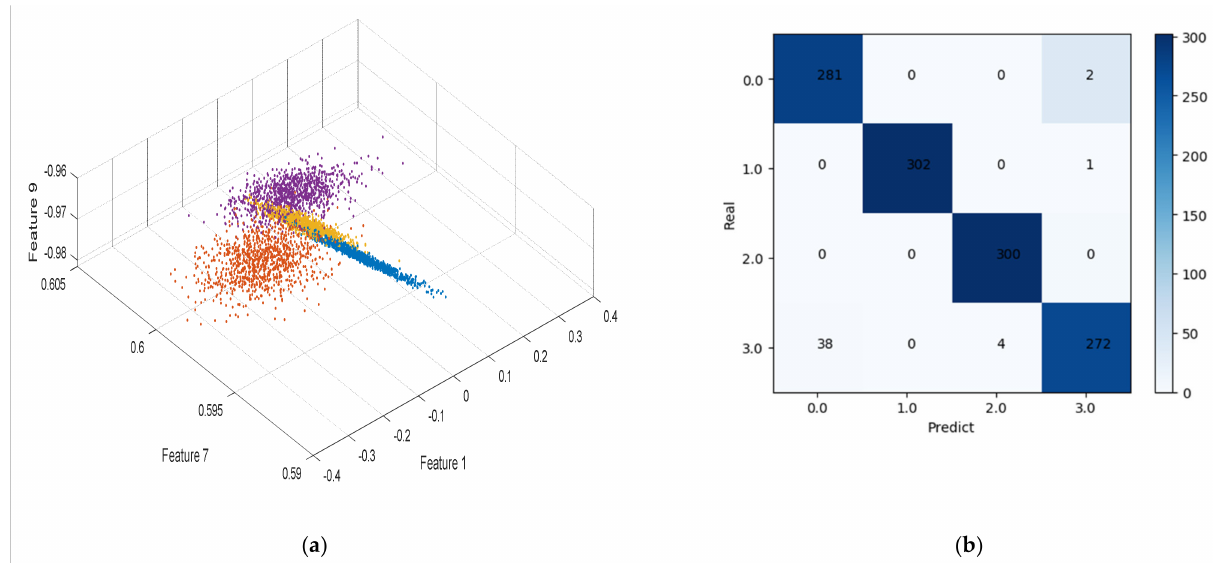
Figure 9. With a SNR ratio of 15 dB: ( a ) three-dimensional visualization map that composed 1-, 7-, and 9-dimensional data of feature vector e; ( b ) confusion matrix corresponding to CNN classification